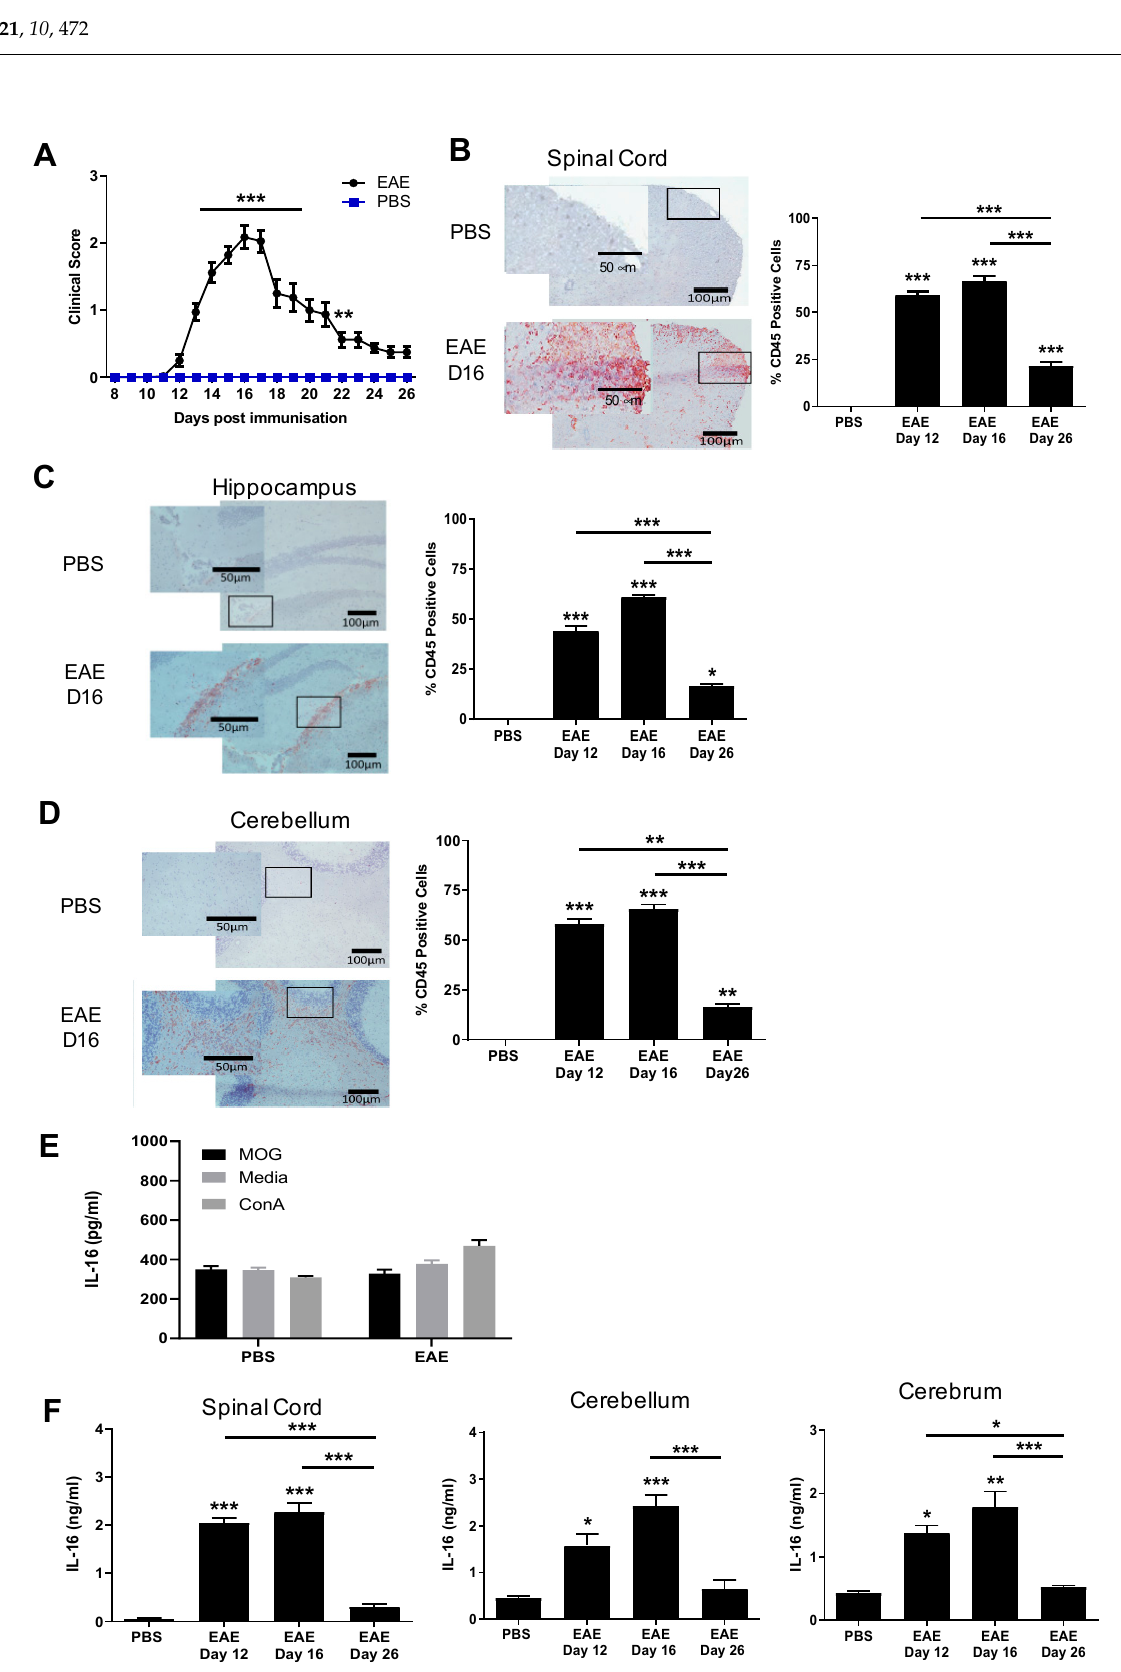
Figure 1. Induction of EAE and IL-16 production by tissues of EAE mice. ( A ) C57BL/6J female mice were injected with MOG 35-55 emulsified in CFA, together with PTX. Clinical symptoms were recorded over the course of 26 days. Control mice received PBS + CFA + PTX immunisation. N = 15. Statistical significance was determined by one-way ANOVA with repeated measures and Bonferroni post-hoc tests. ** p < 0.01, *** p < 0.001. ( B – D ) CNS tissues were harvested from